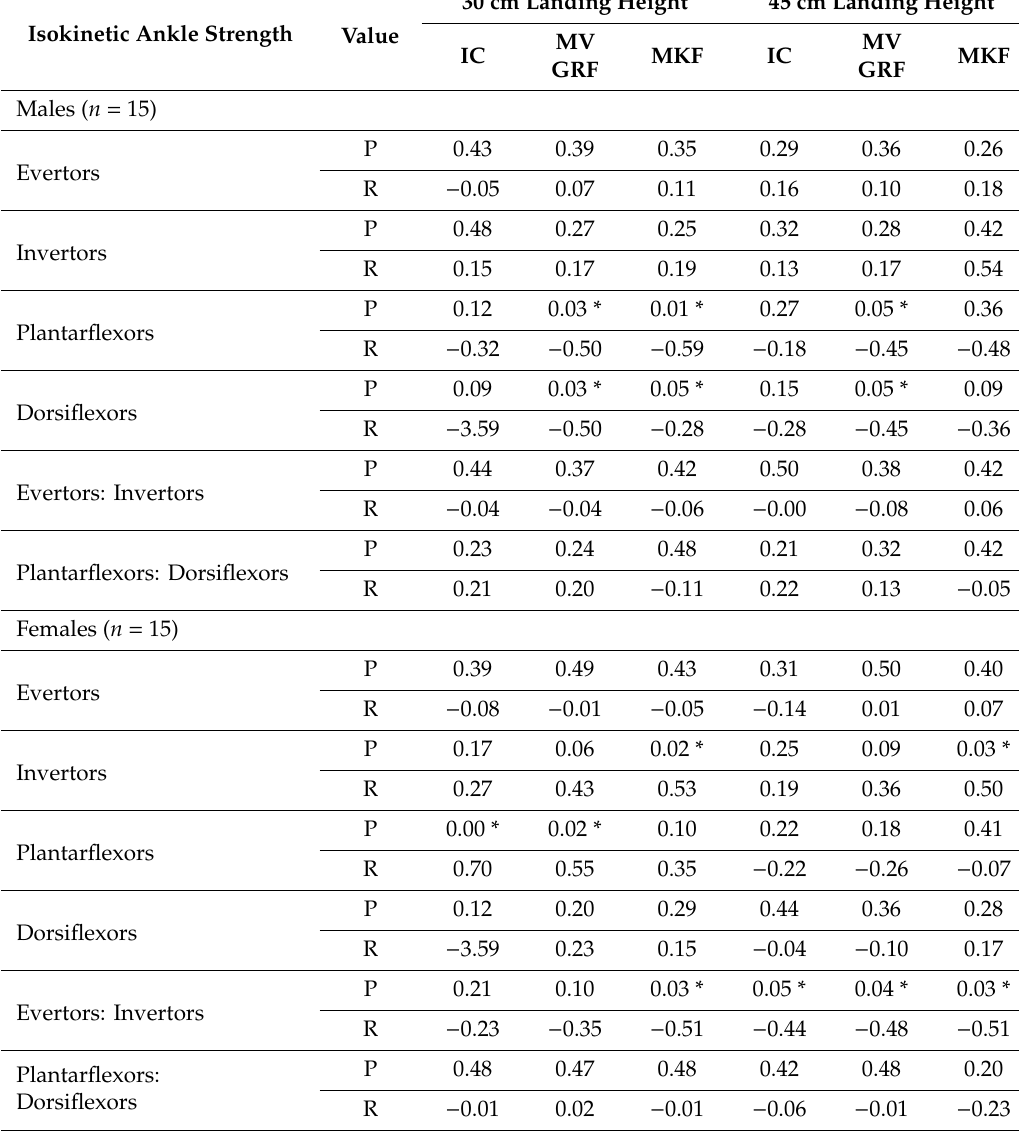
Table 4. Relationship between ankle strength and knee frontal plane projection angle (FPPA) during landing in male and female university athletes ( n =